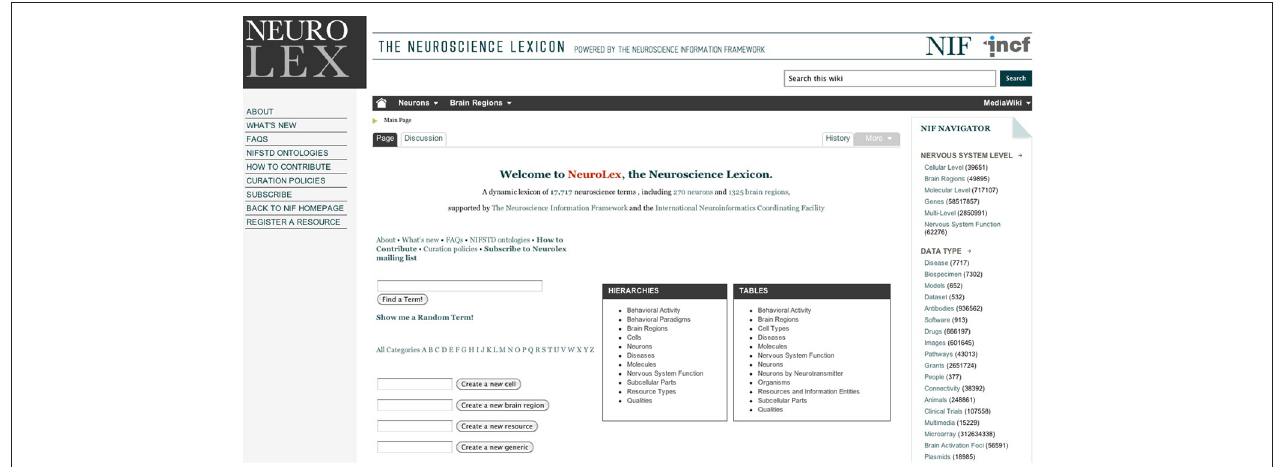
FIGURE 2 | NeuroLex—Neuroscience